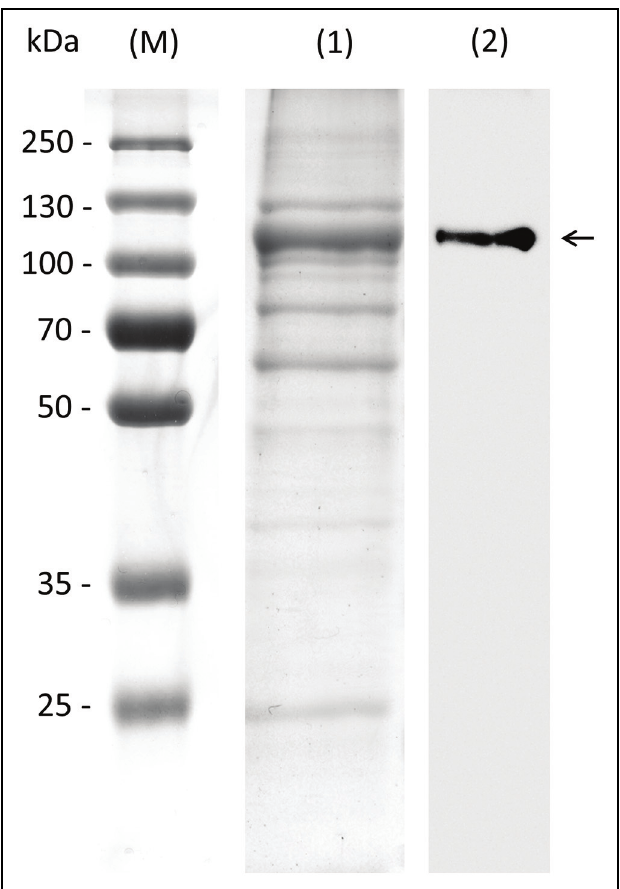
FIGURE 3 | SDS-PAGE and western blot of recombinant AtRS4. Eluate obtained during purification of the recombinant AtRS4 was analyzed on SDS-PAGE and Western Blot. Lane (M), molecular mass marker; Lane (1), SDS-PAGE of purified recombinant AtRS4; Lane (2), Western blot of purified recombinant AtRS4.